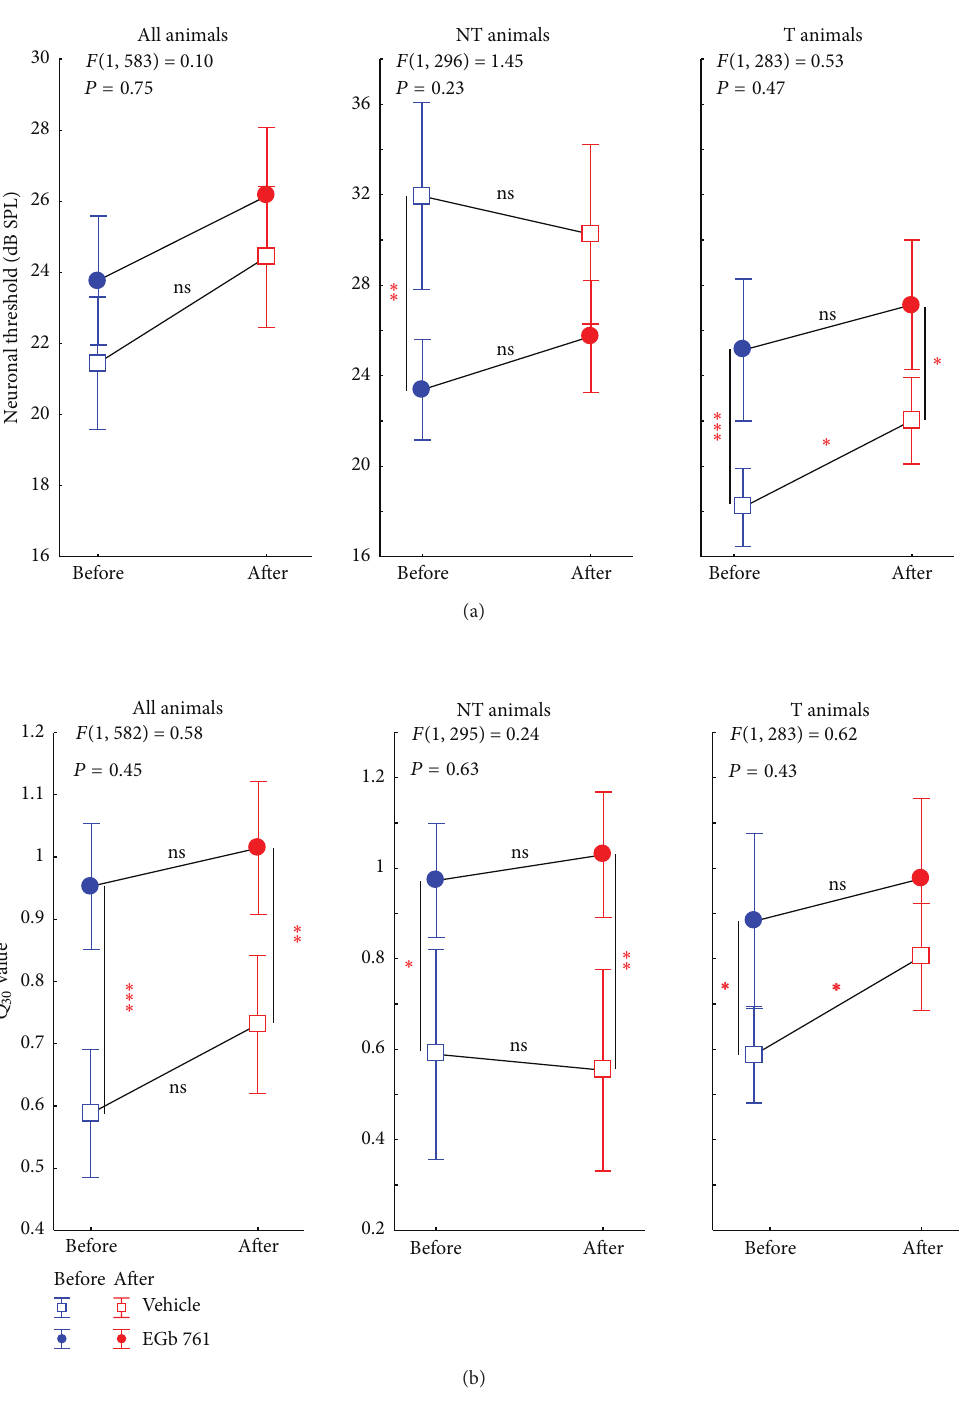
Figure 10: Trauma and treatment induced changes of neuronal response characteristics in NT and T animals. (a) Statistical interaction (with 𝐹 -statistics) of time of measurement (before versus after trauma) and animal group (V versus E) with the mean neuronal threshold ( ± 95% confidence interval) averaged across all animals (left panel) or separated into nontinnitus (center panel) and tinnitus animals (right panel). (b) Statistical interaction of time of measurement and animal group on spectral tuning sharpness ( 𝑄 30 value) with the same grouping as above. Note that none of the statistical interactions become significant while most data show significant differences between V and E animals in the Tukey post-hoc-tests indicated by the asterisks (ns = not significant, ∗ 𝑃 < 0.05 , ∗∗ 𝑃 < 0.01 , ∗∗∗ 𝑃 < 0.001